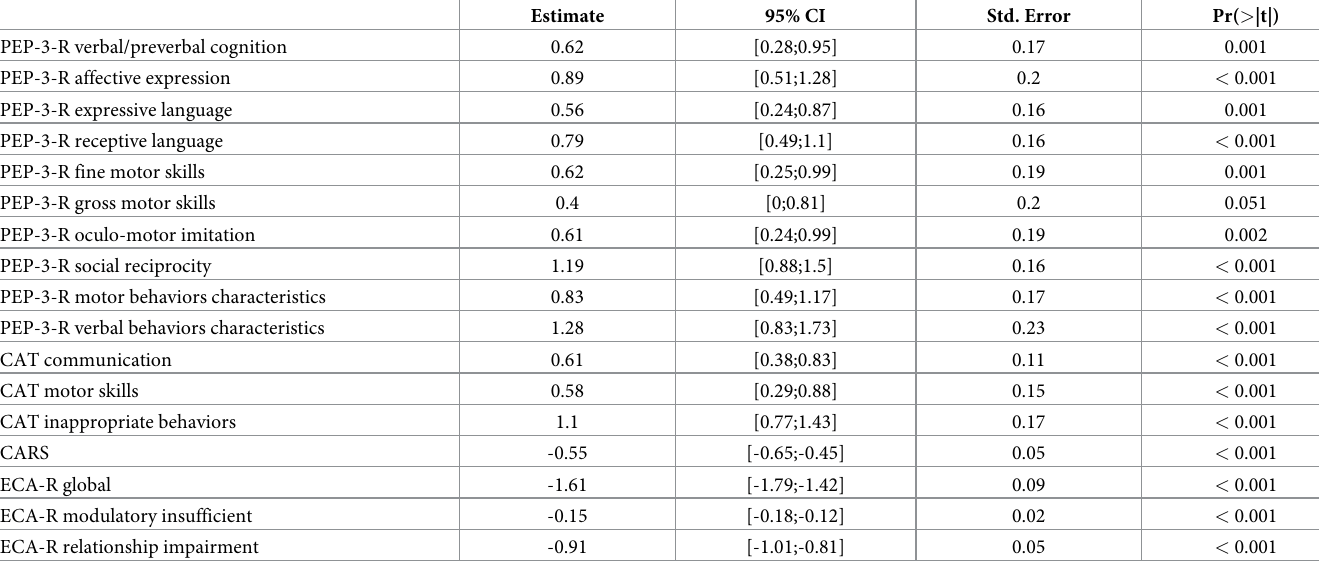
Table 3. Evolution throughout the 12 months for children included in the EPIGRAM study at baseline (N = 89) (time effect model without interaction). Estimate 95% CI Std. Error Pr( >